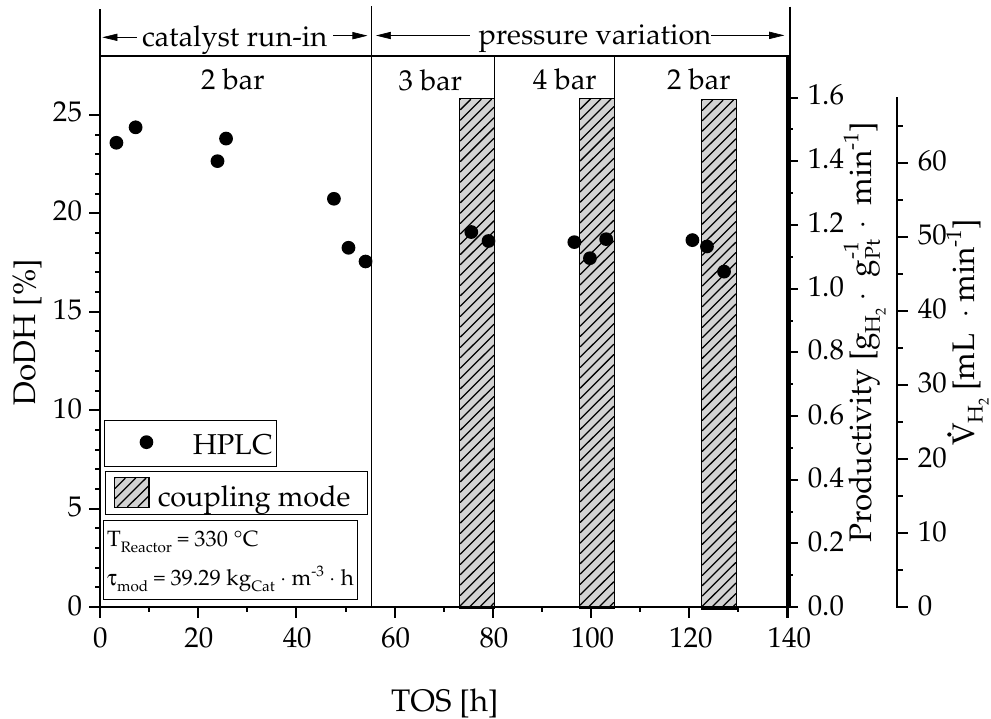
Figure 9. Degree of Dehydrogenation, productivity and produced hydrogen flow, determined by HPLC, during the entire test duration of 140 hours. The shaded areas represent the periods in the coupled mode.